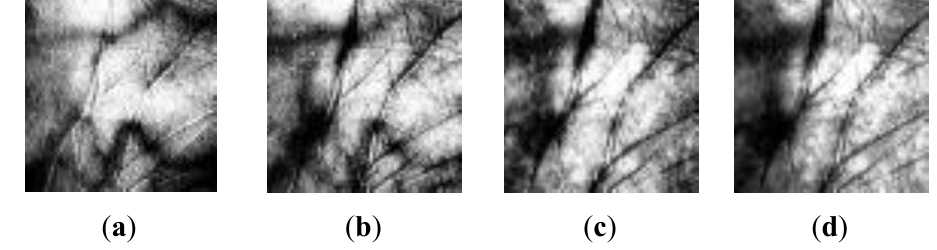
Figure 5. The ROIs of multispectral palmprint images under 4 different kinds of illuminations after the preprocessing and downsampling. ( a ) NIR. ( b ) Red. ( c ) Green. ( d ) Blue.